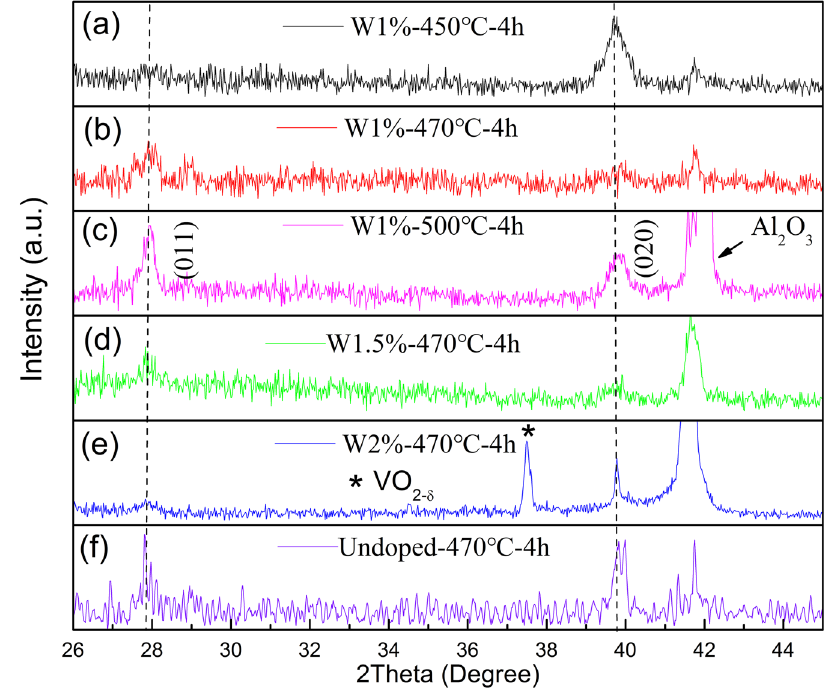
Figure 1. XRD patterns of VO 2 films grown on sapphire substrates, ( a – c ) annealed at 450, 470 and 500 °C for 4 h with nominal 1 at.%W-doping; ( d – f ) annealed at 470 °C for 4 h with nominal 1.5 at.%, 2 at.%W-doping and undoping. The dashed lines are guide for the